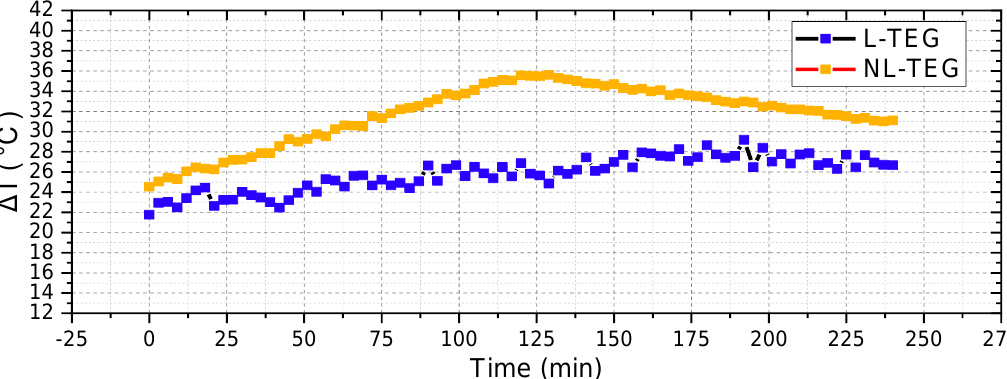
Figure 8. Δ𝑇 for each of NL-TEG and L-TEG system.